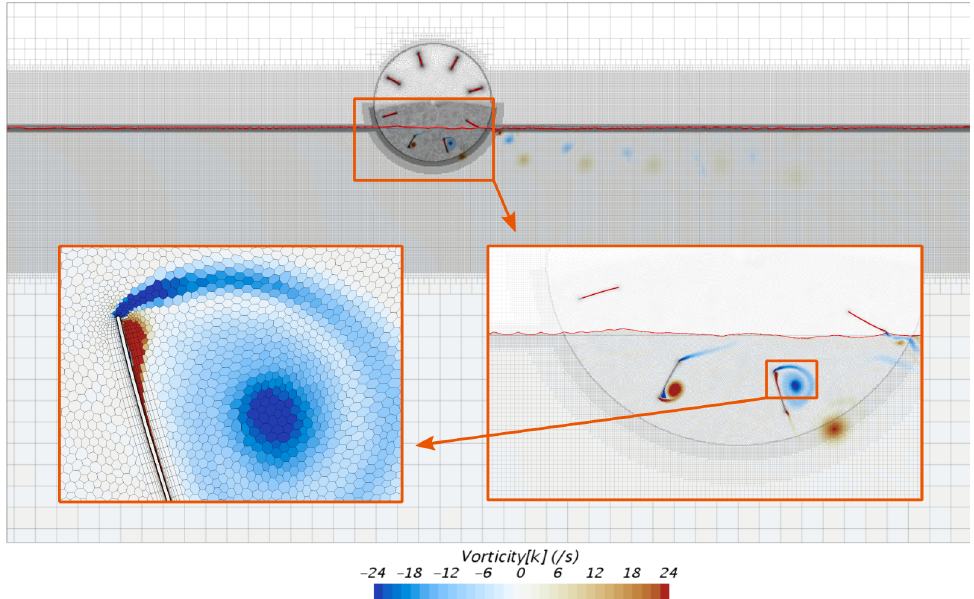
Figure 2. Flow field from one simulation case in the optimisation, displaying the rotating polygonal mesh rotating relative to the fixed trimmed background mesh. Fine prism cells on the blade surfaces bring the average wall y + values down to below 1. Water flows from left to right, and air is above the water surface (red line). Colour denotes vorticity (with the colour scale saturated at The flow is shown after 15s have been